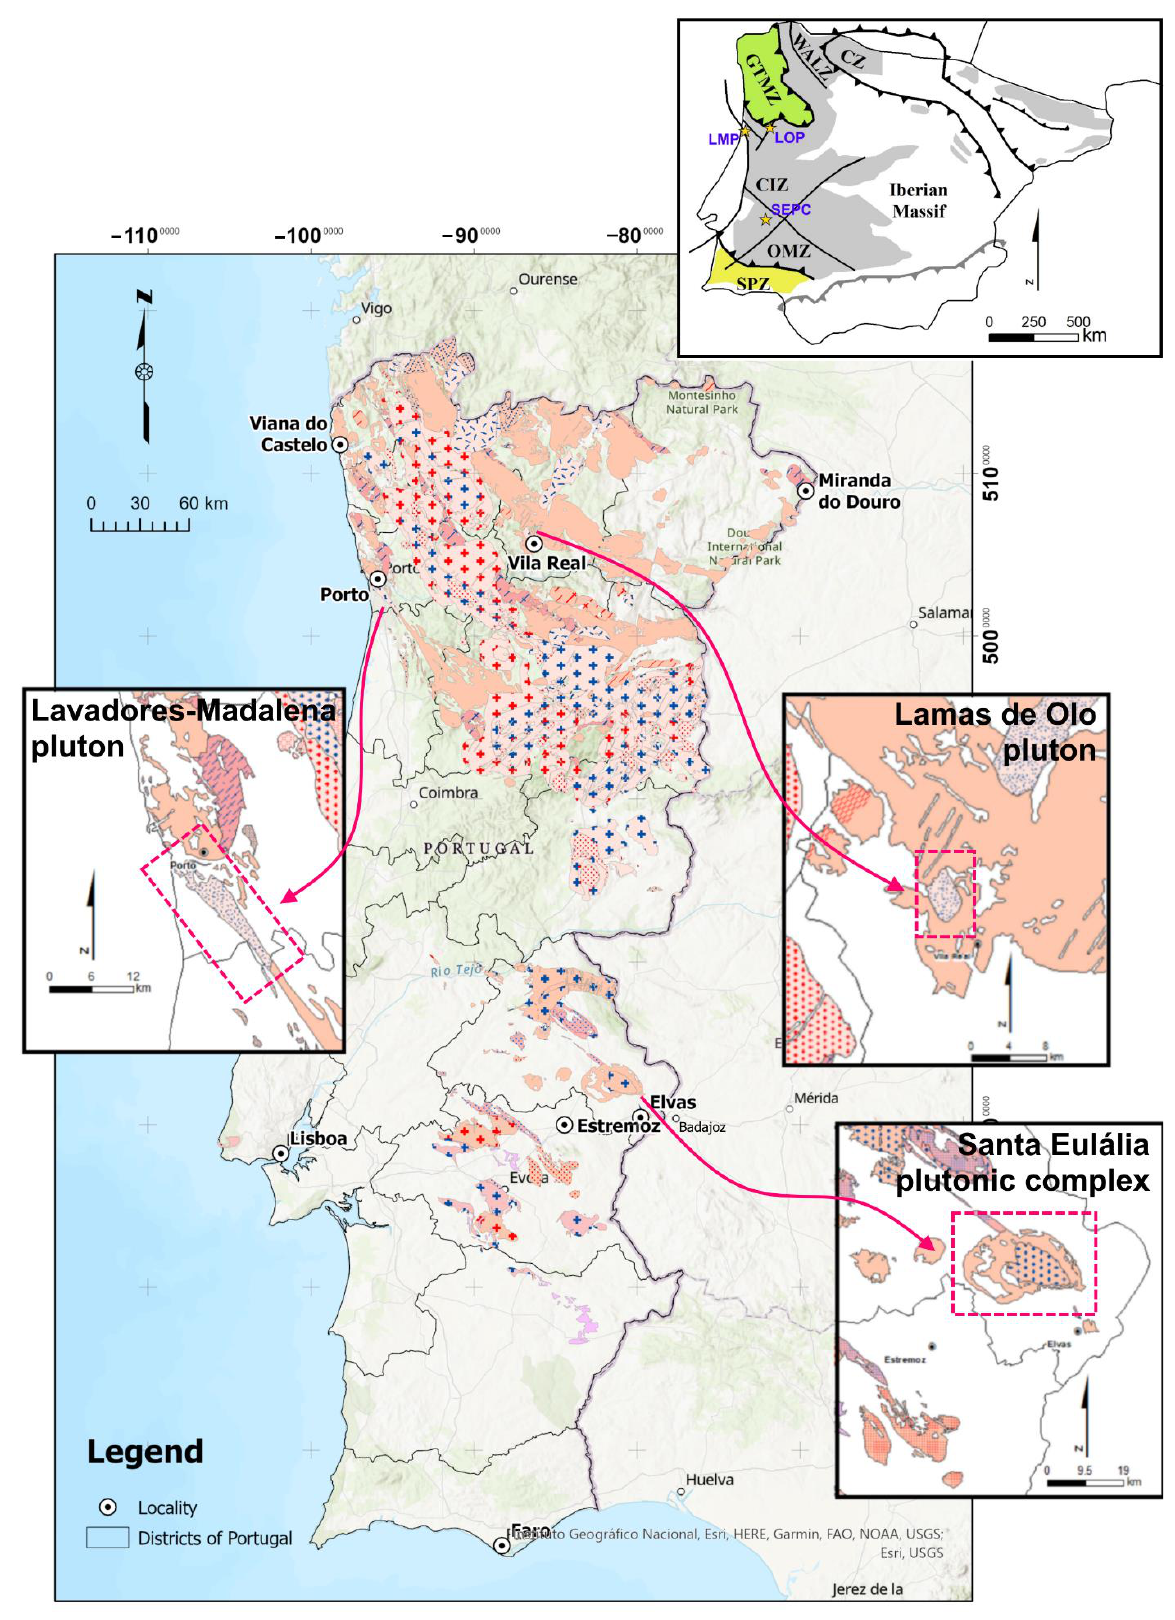
Figure 1. Location of the studied areas in the Iberian Peninsula, and a simplified geological map of studied plutons (Lamas de Olo pluton, Lavadores-Madalena pluton, Santa Eulália Plutonic Com- plex).